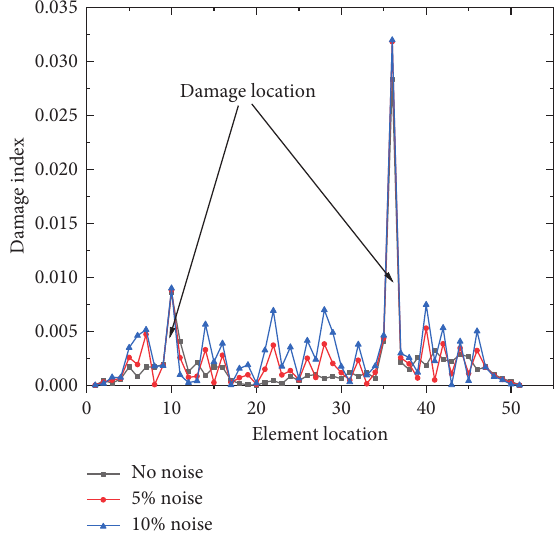
Figure 12: Antinoise verification of damage